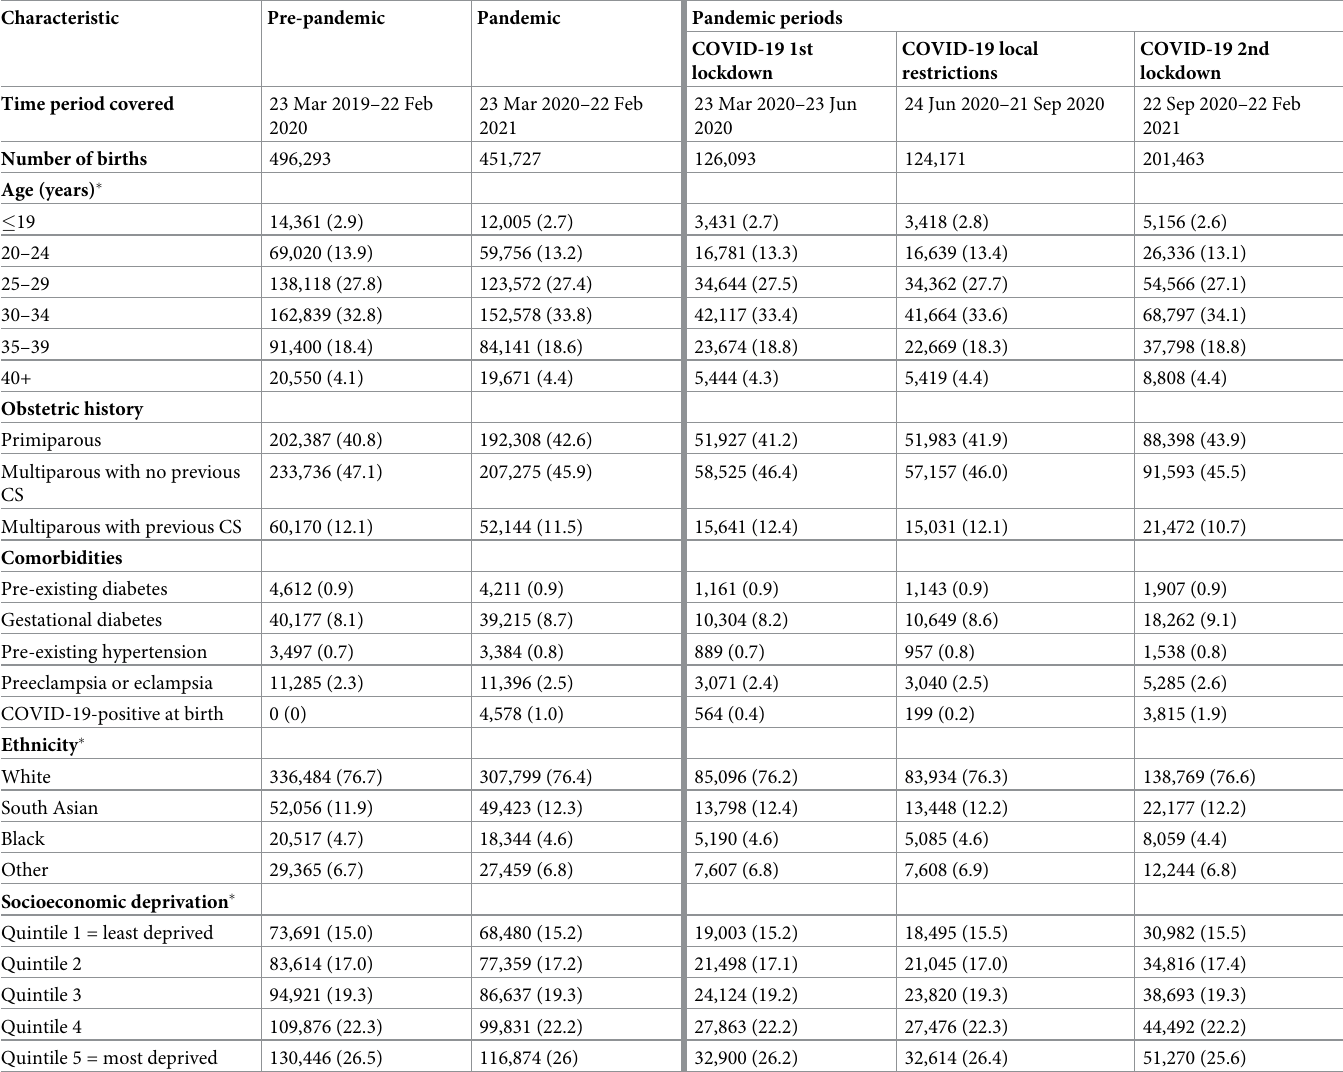
Table 1. Characteristics of pregnant women included in the